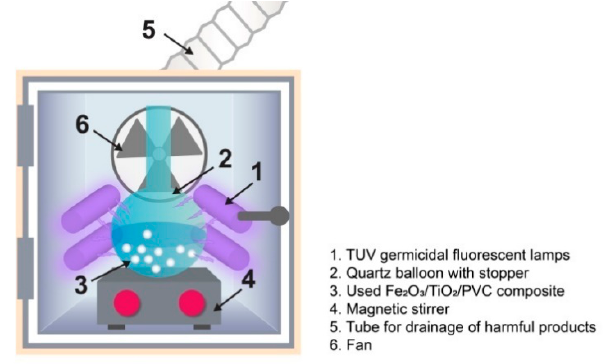
Figure 2. Schematic diagram of the laboratory-made photo-cleaning chamber [25]. Reproduced with permission from [25]. Copyright Springer, 2022.